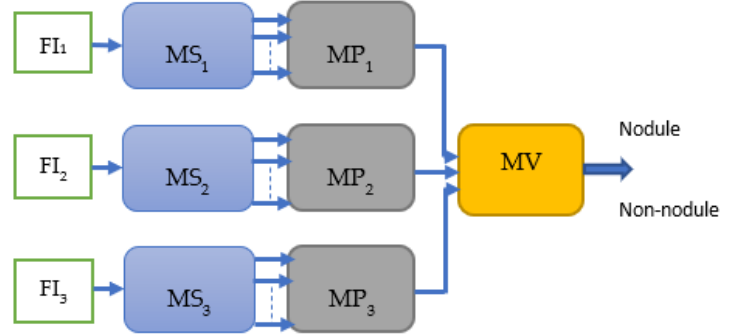
Figure 7. Block diagram of the proposed SFMPF model.